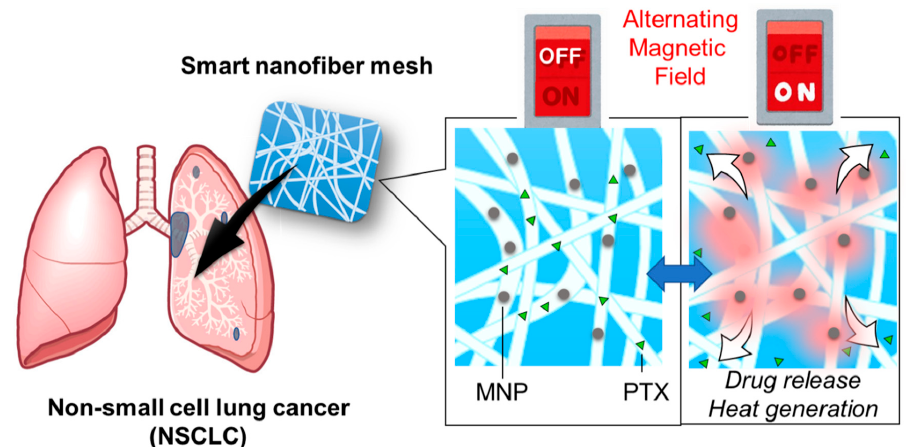
Figure 1. Schematic illustration for on–off switchable temperature-responsive fiber mesh for cancer thermo-chemotherapy. The mesh contains paclitaxel (PTX) and magnetic nanoparticles (MNPs). The mesh releases heat and drug when activated in alternating magnetic field (AMF).